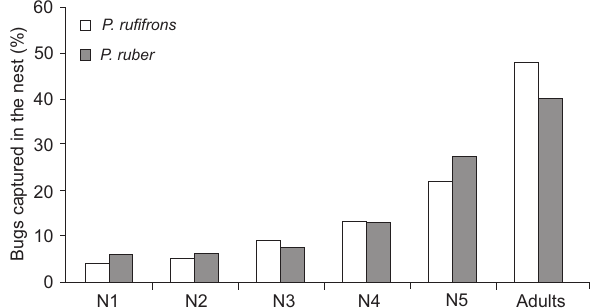
Figure 1. Percentage of Psammolestes tertius specimens captured in the nests of Phacellodomus rufifrons and P. ruber , according to their development stages. (N) Nymphs.